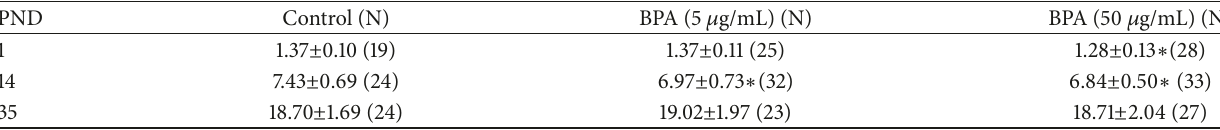
Table 2: Body weights of pups (g).